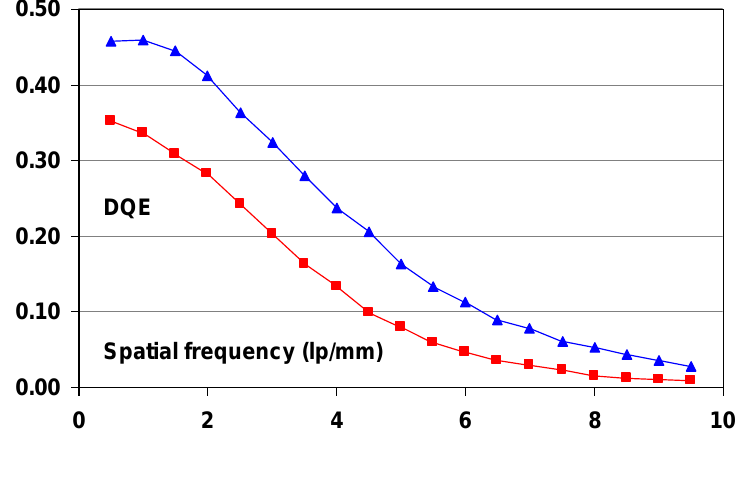
Figure 40. Measured PIP (red squares) and NIP (blue triangles) CR systems’ DQE (lines) (data from